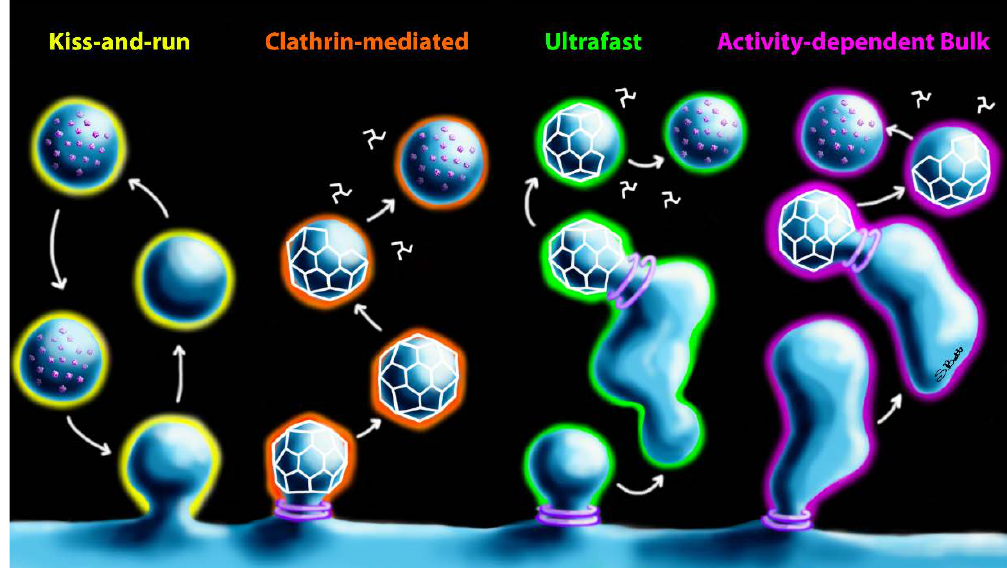
Figure 3. Comparison of the four proposed modes of synaptic endocytosis: kiss-and-run, clathrin-mediated endocytosis (CME), ultrafast endocytosis (UFE), and activity-dependent bulk endocytosis (ADBE). Formation of the clathrin coat is represented by white cages, with clathrin disassembly depicted by white pinwheels. Purple rings represent dynamin rings during membrane scission. Purple spheres indicate neurotransmitter filling during SV biogenesis. For all modes of endocytosis, the final stage is a regenerated SV ready for inclusion in release pools.